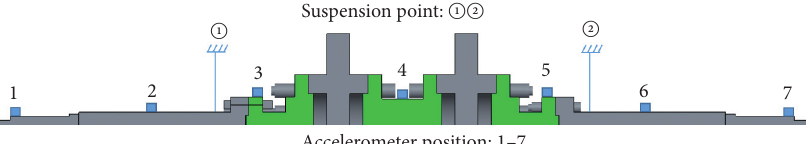
Figure 2: Arrangement of accelerometer and suspension locations for the tie-bolt rotor. Table 1: Experimental modal testing with different preloads. Modal tests